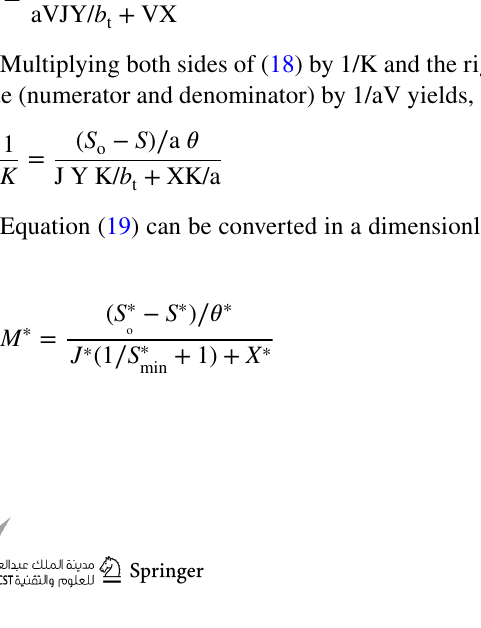
Fig. 4 (Qw Xu) * as a function of S * and ( S ∗ o − S )/HRT at Y K / K L * = 1.0, S ∗ min =